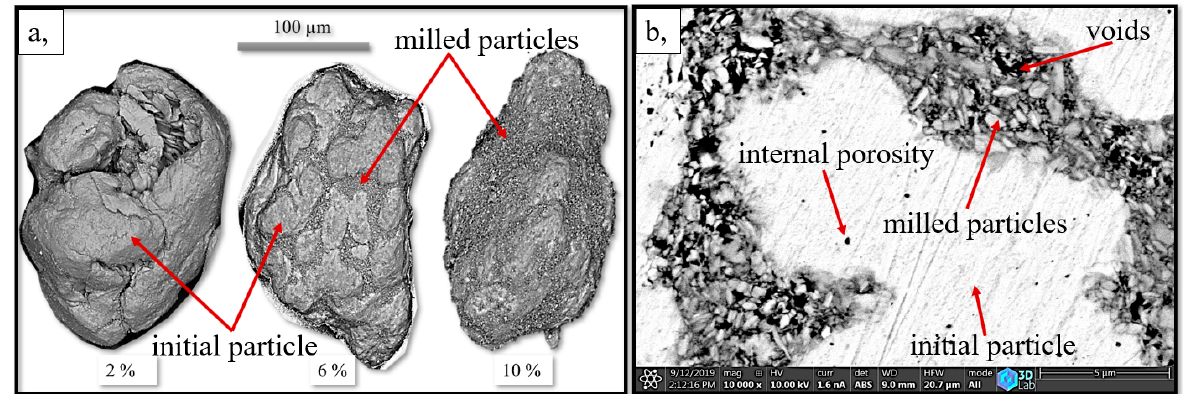
Figure 3. ( a ) Morphology of the typical particles after mixing the initial powder with 2 wt.%, 6 wt.% and 10 wt.% milled powder; ( b ) typical SEM images of the green sample which contain 10 wt.% milled powder.